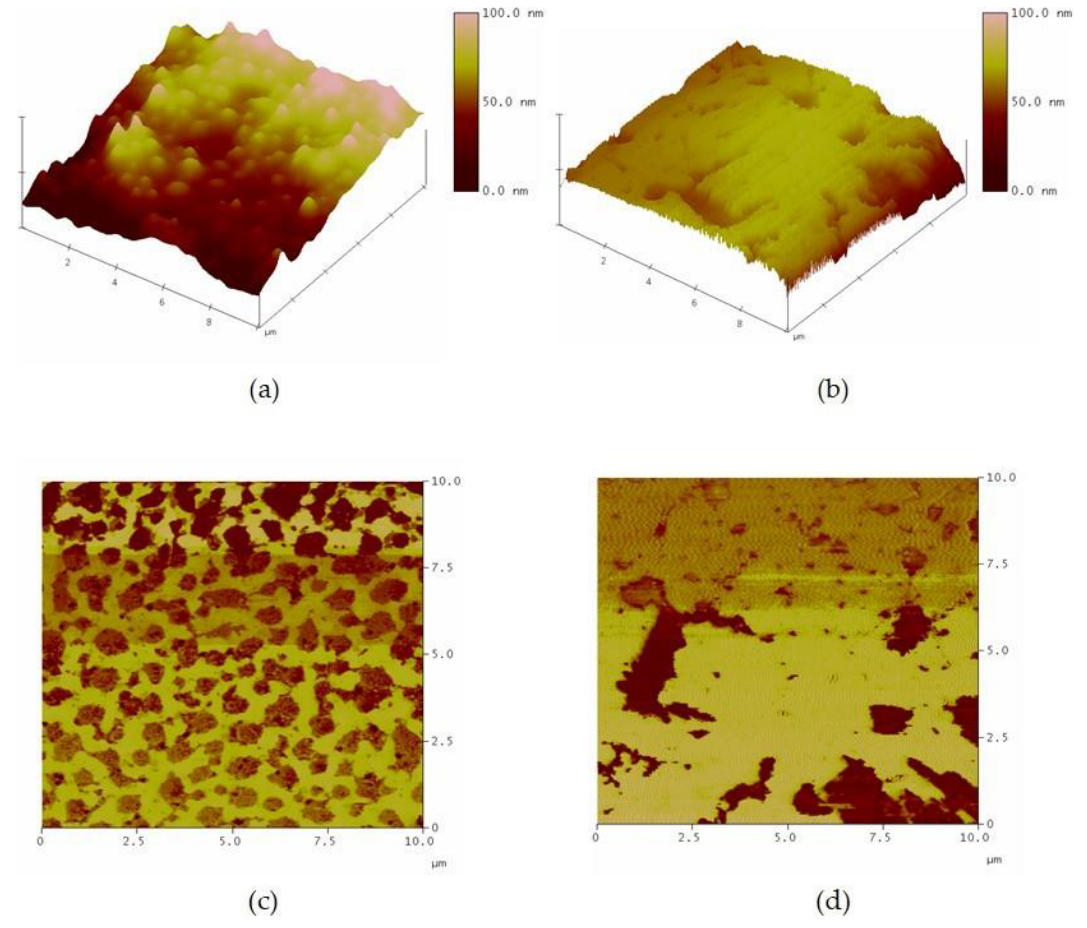
Figure 9. AFM topology (height image and phase image) of DPNR particles ( a , c ) before the photo- chemical process, and ( b , d ) after the photochemical process with 20% H 2 O 2 and TiO 2 film coated on quartz substrate under UV light for 5 h.